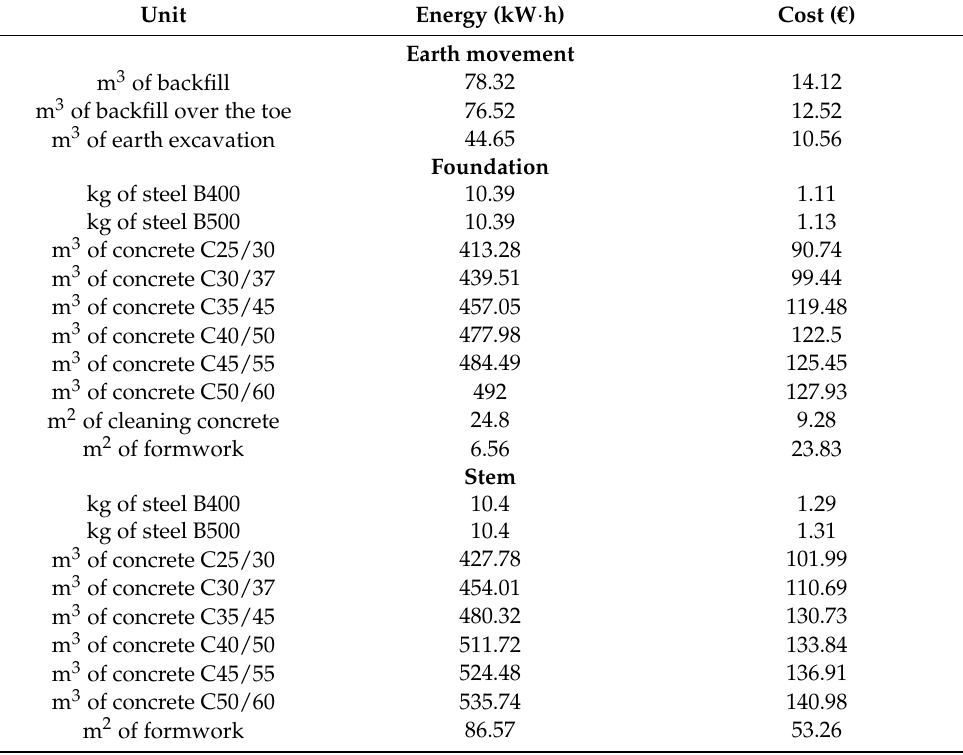
Table 1. Prices and embodied energy values of the construction units